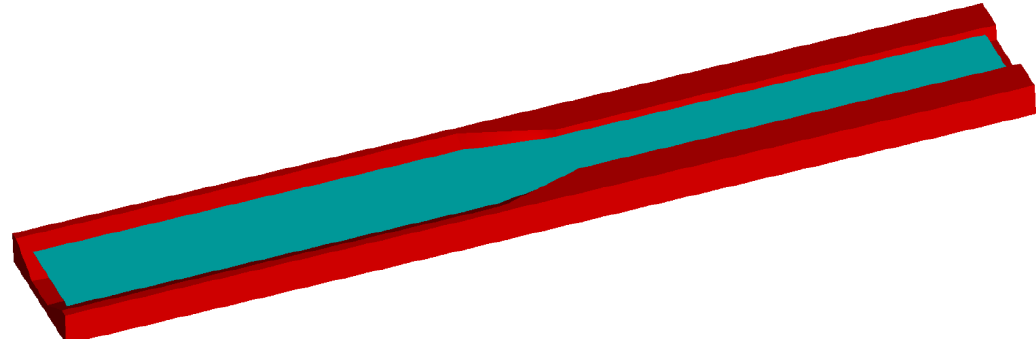
Figure 5. Prototype inlet gradient section model diagram. Table 4. Values of W up and W down for the models’ working conditions.